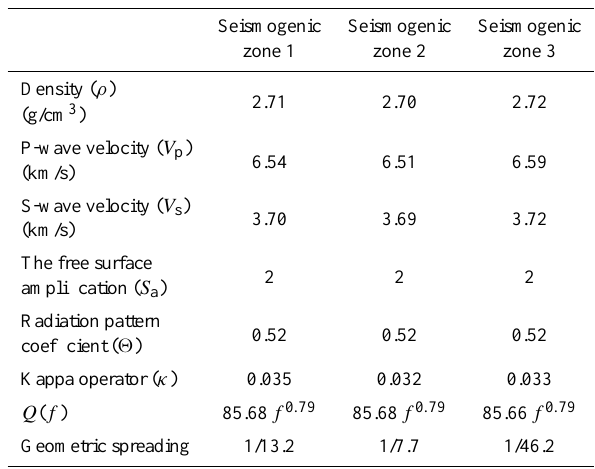
Table 2. Modelling parameters for the application of the source parameters, Mmax and PGA estimation from different seismogenic zones in and around Greater Cairo